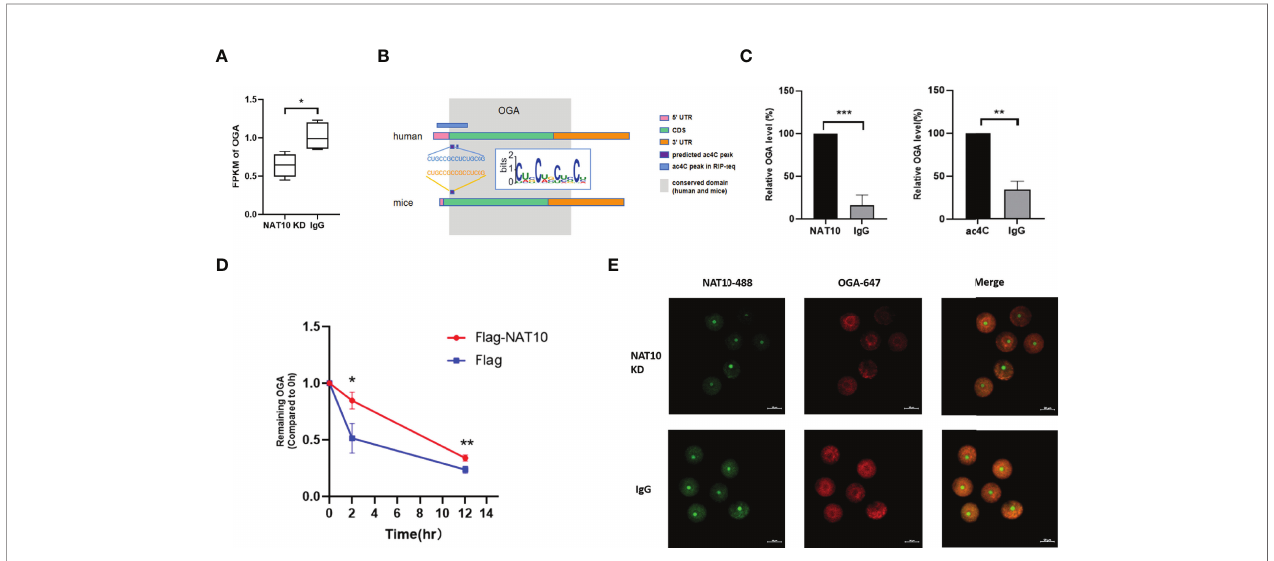
FIGURE 3 | OGA Stability was modulated by NAT10-mediated ac4C modi fi cation. (A) Expression of OGA was downregulated signi fi cantly by comparing NAT10 KD transcriptome with the control. (B) The diagram displayed ac4C-modi fi ed potential sites of OGA in homo sapiens and Mus musculus. (C) Bar chart showed OGA could bind to NAT10 and be ac4C-modi fi ed by RIP. (D) The degradation of OGA was suppressed in NAT10-overexpressing compared with negative control group. (E) Immuno fl uorescence showed NAT10 degradation and OGA downregulation after NAT10 KD by Trim-Away. Data represent the mean ± SEM of at least three independent experiments. * P < 0.05, ** P < 0.01, and *** P < 0.001.